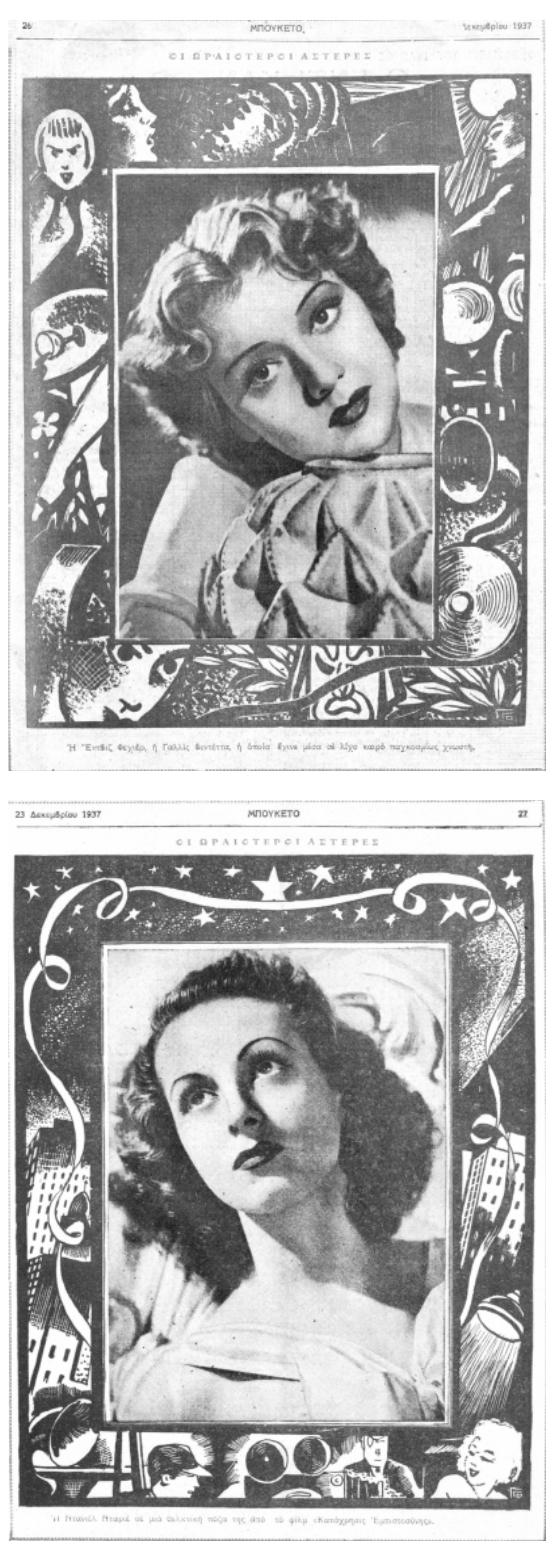
Figs 5 and 6 ‘The most beautiful stars’. A unique centrefold for the Christmas issue in 1937. The frame decoration bears the signature of Gerasimos